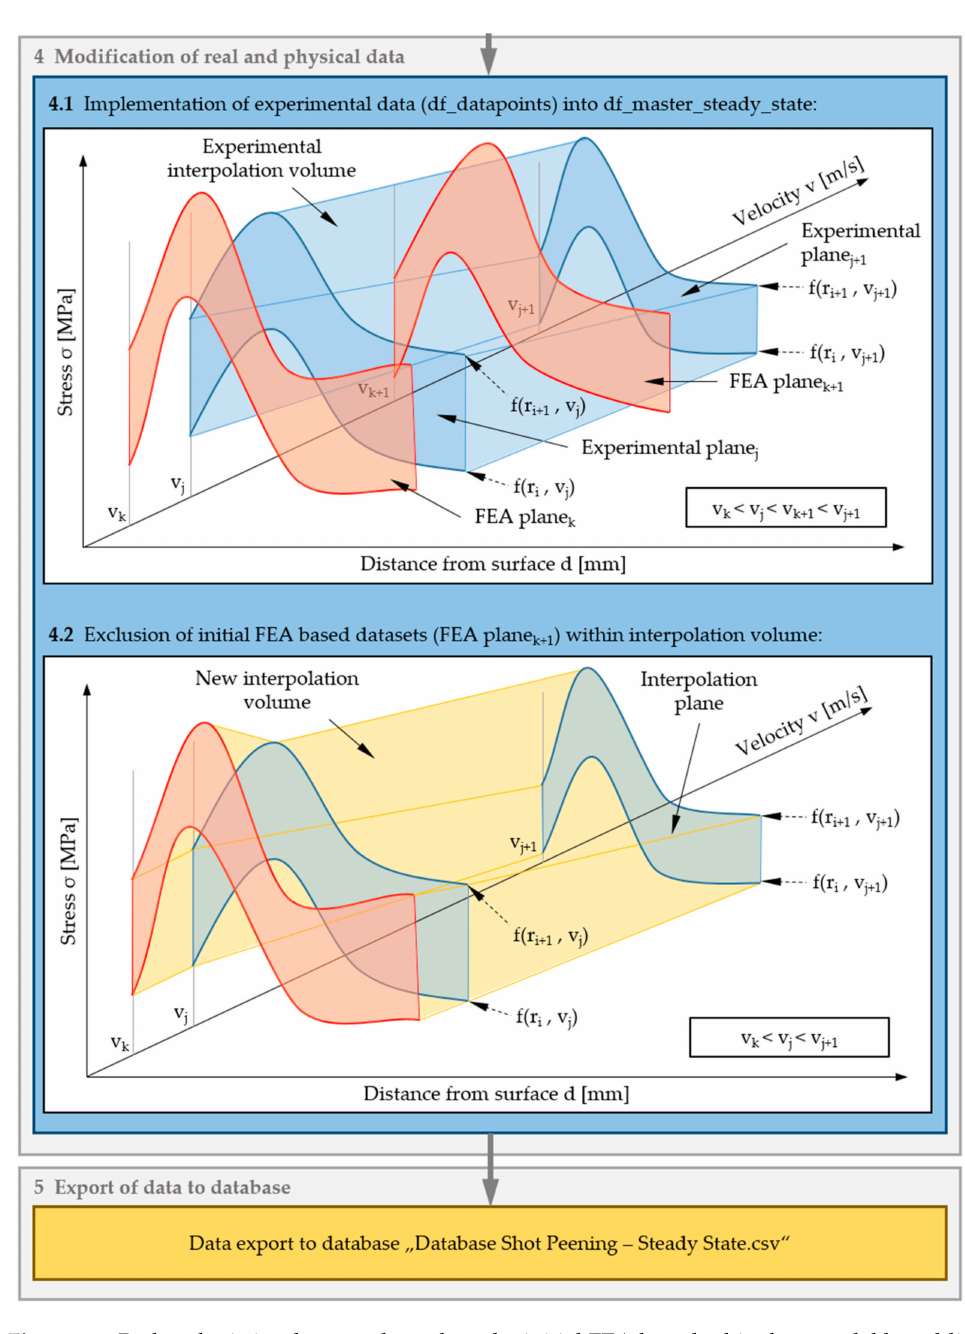
Figure 11. Python logic implemented to adapt the initial FEA based white-box model by adding data from residual stress experiments. 1: Import data; 2: generation of support data points from experimental data and storage in a new data frame; 3: loading master data frame; 4: import data points from 2 and overrule data points of the master data frame to increase prediction efficiency; 5: overwrite master database with new data